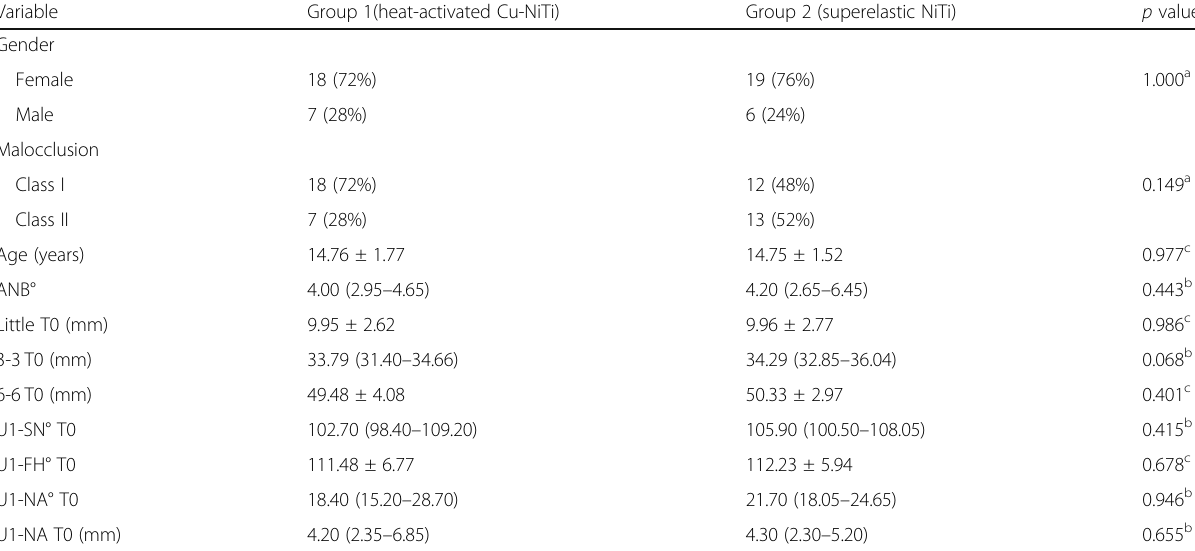
Table 1 Demographic distribution of subjects and baseline data for the groups Variable Group 1(heat-activated Cu-NiTi) Group 2 (superelastic NiTi) p